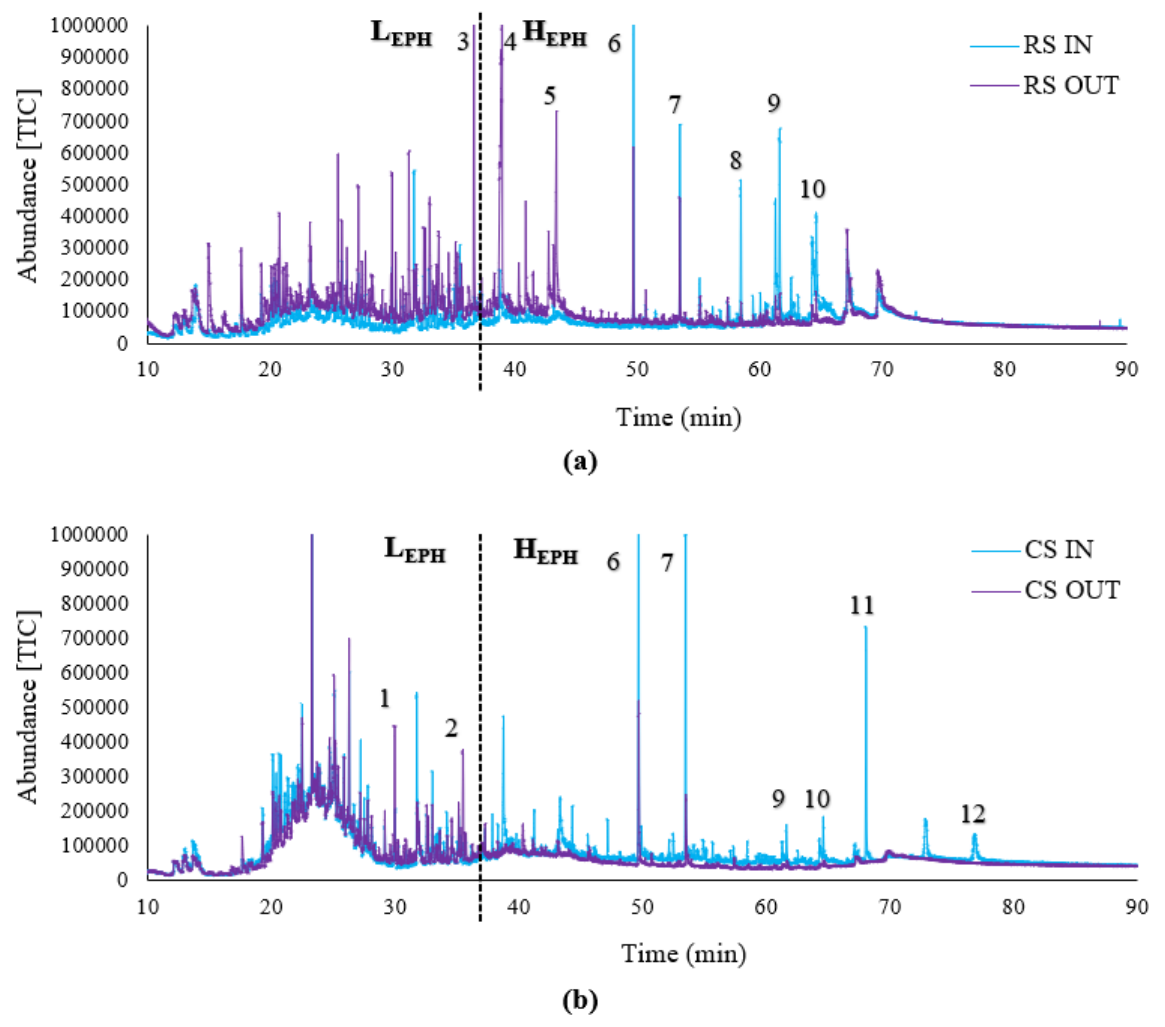
Figure 4. C 10 -C 40 chromatograms for RS ( a ) and CS ( b ) before and after AD. Numbered peaks dis-